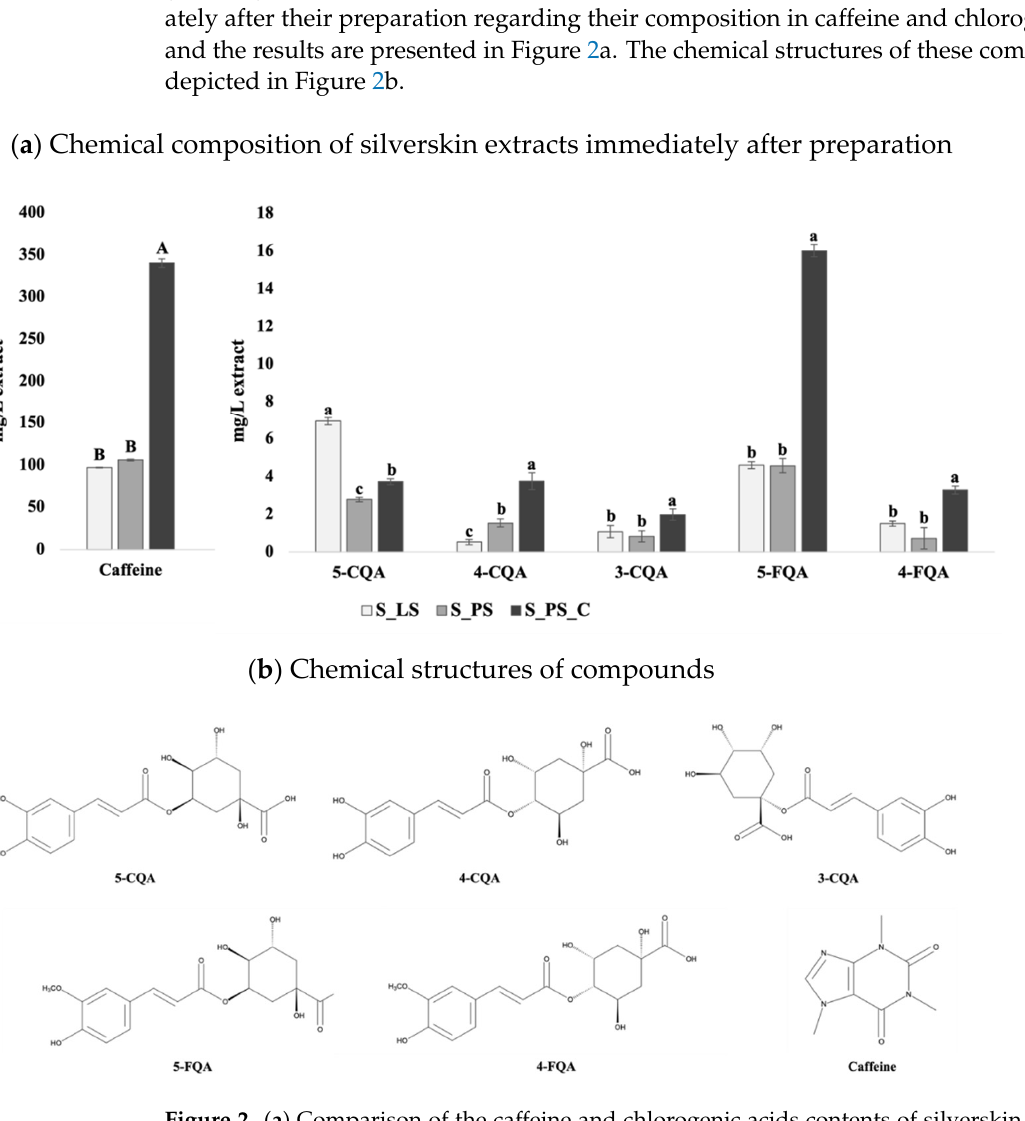
Figure 2. ( a ) Comparison of the caffeine and chlorogenic acids contents of silverskin extracts (ex- pressed in mg/L of extract) prepared under different conditions (S_LS: laboratorial scale; S_PS: pilot scale; S_PS_C: pilot scale_ concentrated). The samples were analyzed immediately after prepara- tion. Different letters for each compound denote significant differences between samples at p < 0.05. ( b ) Chemical structures of caffeine, 5-CQA, 4-CQA, 3-CQA, 5-FQA, and 4-FQA. CQA,